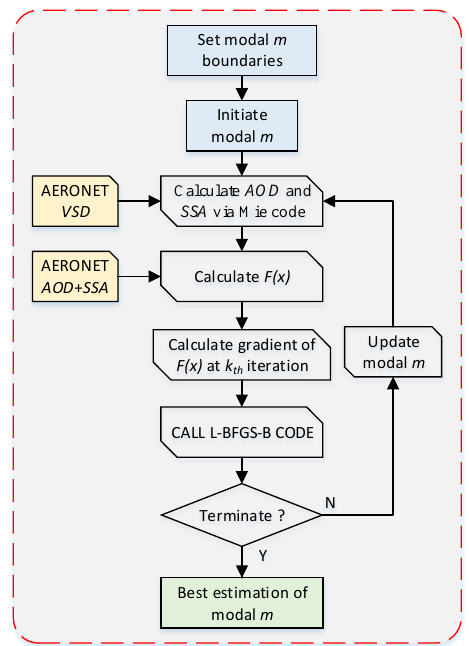
Figure 2. Flow diagram showing the process for estimating modal aerosol refractive indices m ; AOD, SSA, and VSD represent aerosol optical depth, single scattering albedo, and volume size distribution, respectively; modal m donates fine-mode and coarse-mode aerosol refractive index; F ( x ) is the target function.